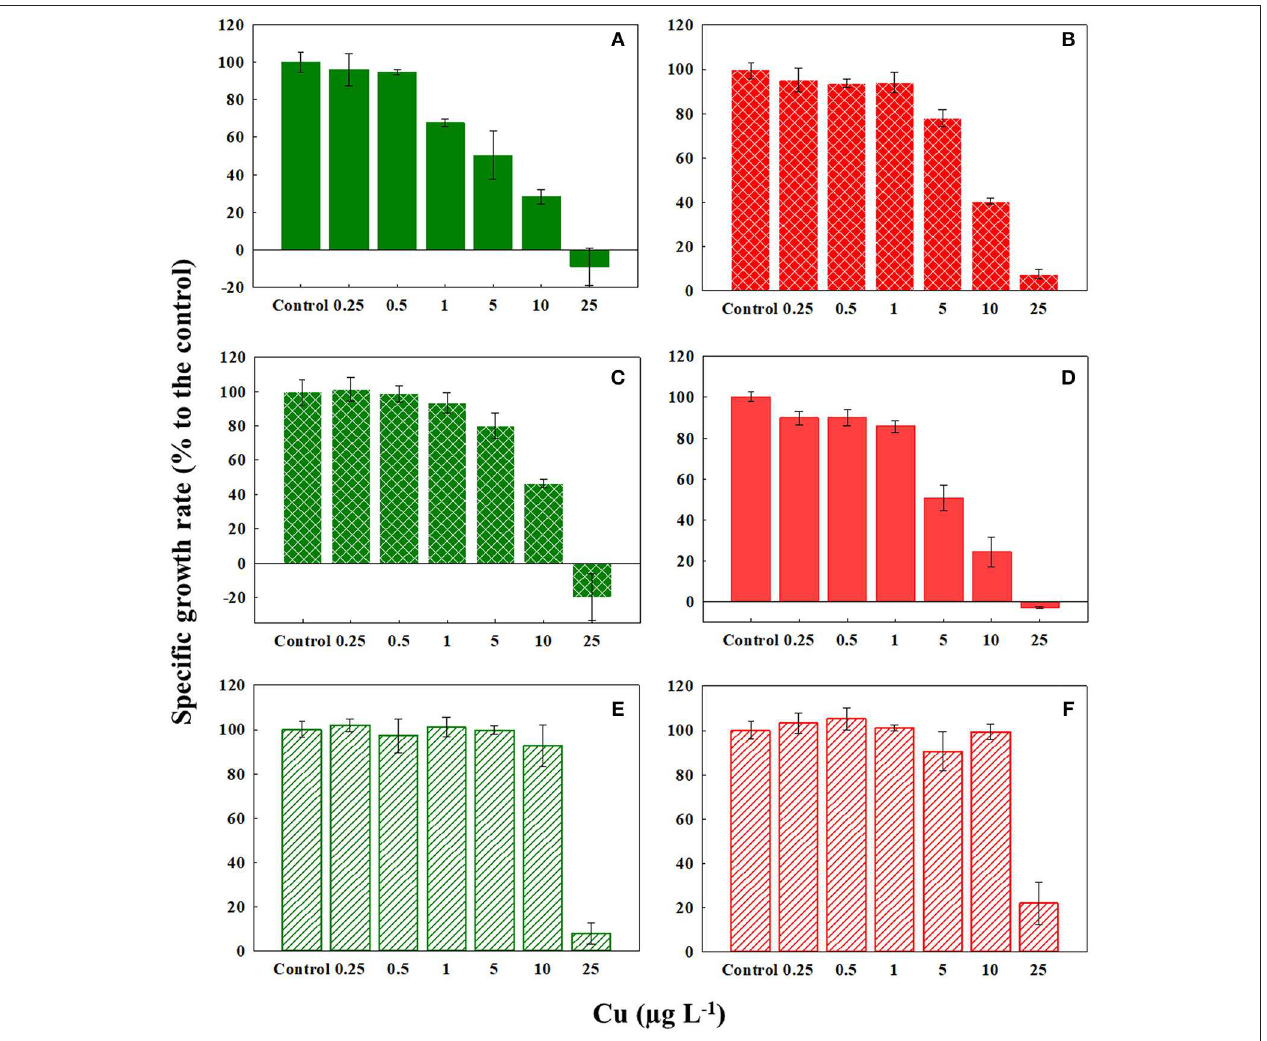
FIGURE 2 | Response of the specific growth rate ( µ ) of ambient-adapted (green) and warming-adapted (red) strains of Chaetoceros tenuissimus to Cu exposure at various temperatures: (A) ambient-adapted tested at 26 ◦ C, (B) warming-adapted tested at 26 ◦ C, (C) ambient-adapted tested at 30 ◦ C, (D) warming-adapted tested at 30 ◦ C, (E) ambient-adapted tested at 35 ◦ C, and (F) warming-adapted tested at 35 ◦ C. Solid fills: Cu test at selection temperatures, textured fills: Cu test at reciprocal transplants and line fills: Cu test at 35 ◦ C. Data are plotted as treatment means with error bars ± SD.